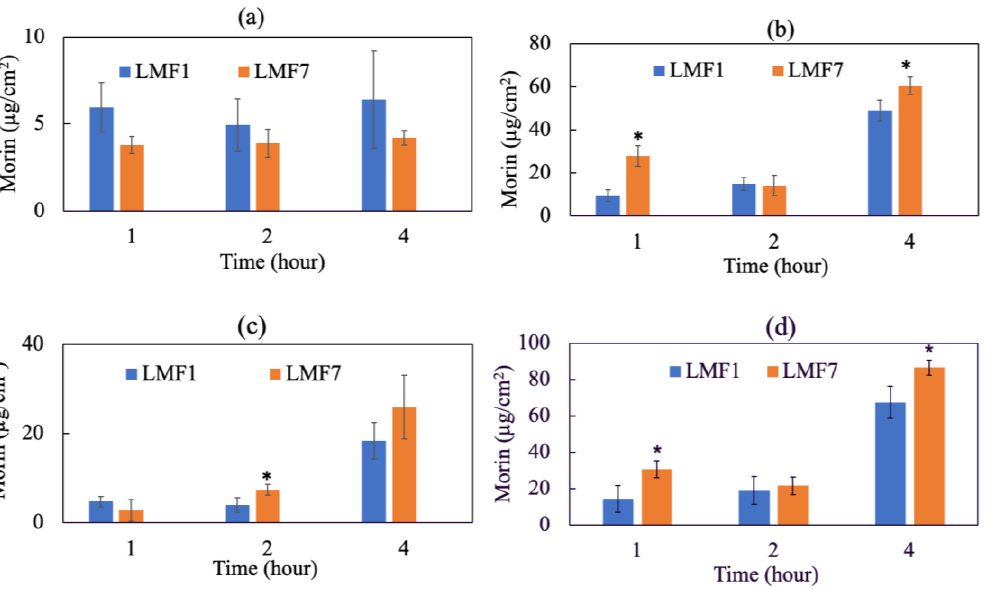
Figure 8. Skin penetration of liposomal morin formulation 1 (1:20:20:5) (LFM1) and 7 (1:2.5:2.5:5) (LMF7) in water using the FDC method and pork skin: ( a ) stratum corneum, ( b ) viable epidermis (epidermis without stratum corneum), ( c ) dermis and ( d ) total dermal absorption. There was no morin found in the receptor fluid. Data were presented as mean ± SD and from triplicate experiments. * indicates a statistically significant difference between LMF1 and LMF7, p < 0.05.